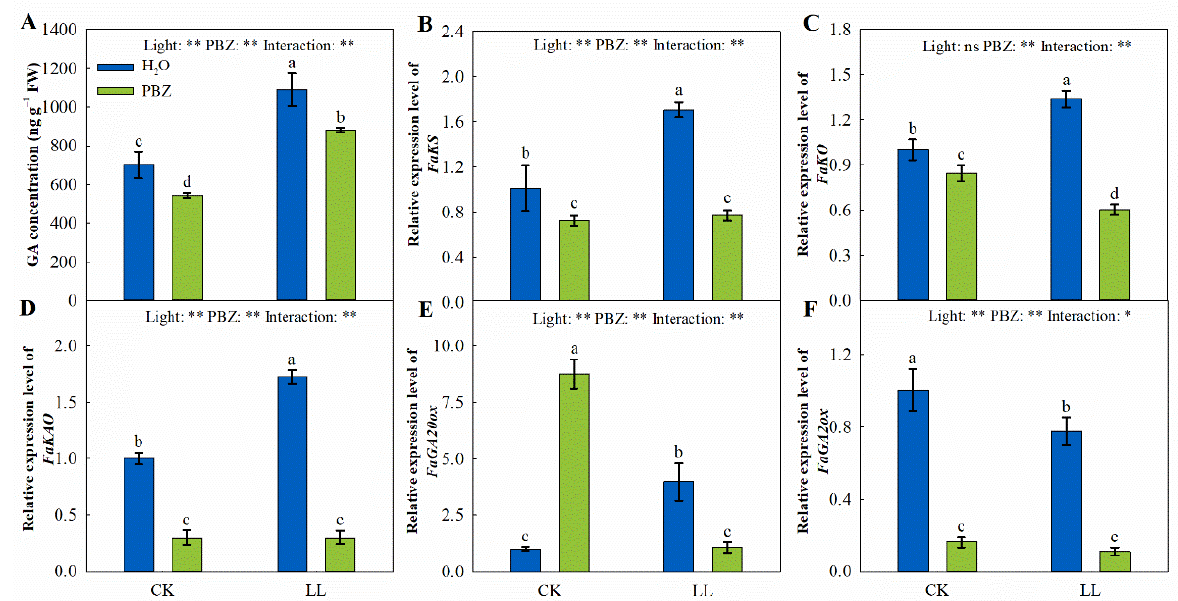
Figure 7. Changes in GA concentration ( A ), FaKS expression level ( B ), FaKO expression level ( C ), FaKAO expression level ( D ), FaGA20ox expression level ( E ), and FaGA2ox expression level ( F ) of tall fescue leaves induced by paclobutrazol under control (CK) and LL stress. * and ** indicate significant differences at p < 0.05 and p < 0.01, respectively. ns indicates not significant. Different letters above the vertical bars indicate significant differences at p < 0.05 according to Duncan’s multiple range test.